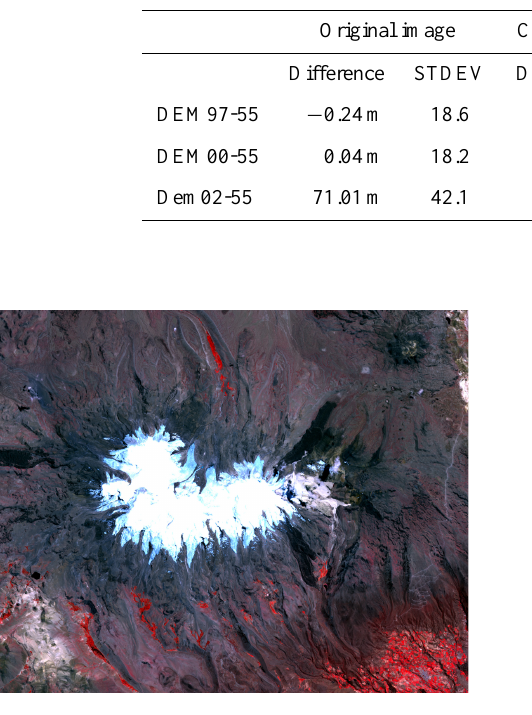
Fig. 5. ASTER 2008 image (band 1, 2, 3).